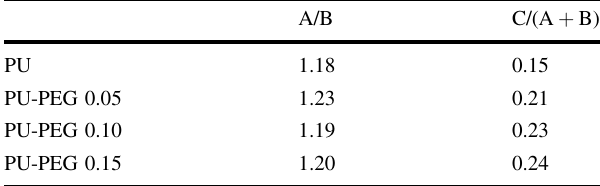
Fig. 3 Deconvolution of carbonyl bands from 1800 to 1600 cm – 1 . The signals at 1719 cm − 1 ( A ) are assigned to non-hydrogen-bonded car- bonyls, 1695 cm − 1 ( B ) to hydrogen-bonded carbonyls, and 1663 cm − 1 ( C ) to carbonyls from allophanate groups Table 1 Carbonyl FTIR band